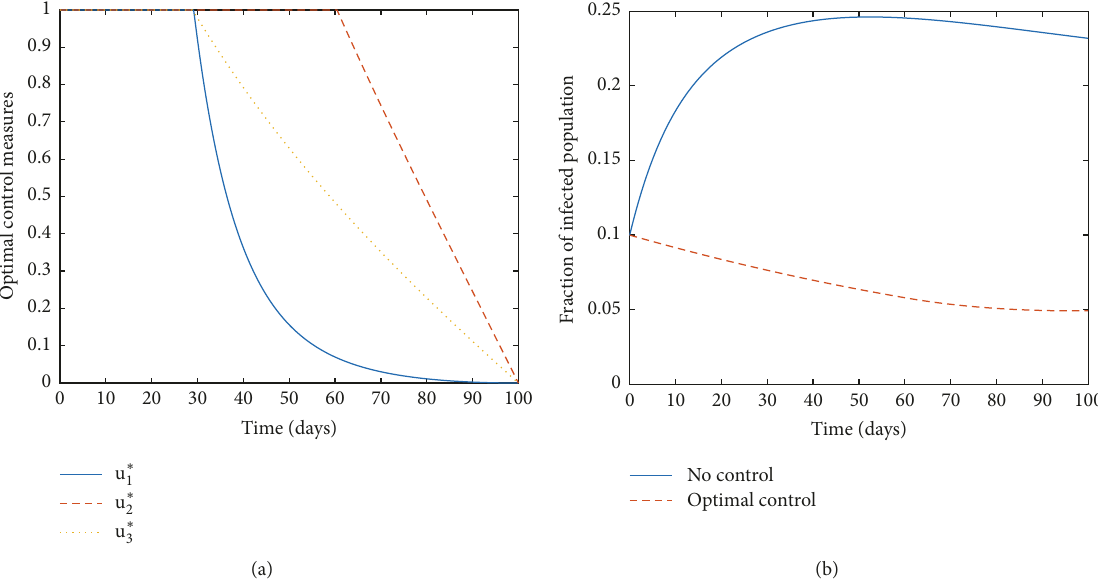
Figure 2: Graphical illustration of (a) the optimal control functions 𝑢 ∗ 1 , 𝑢 ∗ 2 ,𝑢 ∗ 3 and (b) impact of considering optimal control over no control in reducing the spread of waterborne